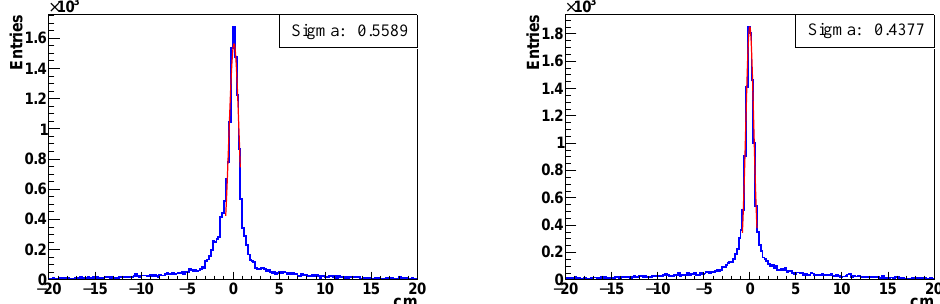
Figure 4. The di ff erence between the coordinate of the extrapolated track from DCH and the coordinate measured in the CSC for the X coordinate (left) and for the Y coordinate (right). Sigma are 0.5589 and 0.4377